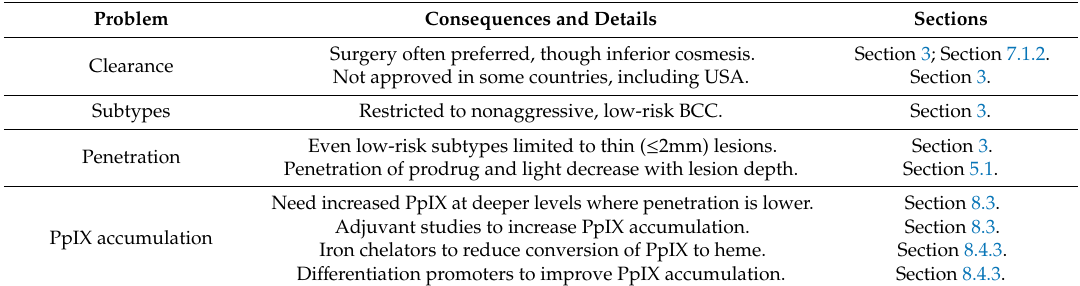
Table 1. Problems concerning the e ffi cacy limitations of PDT for BCC